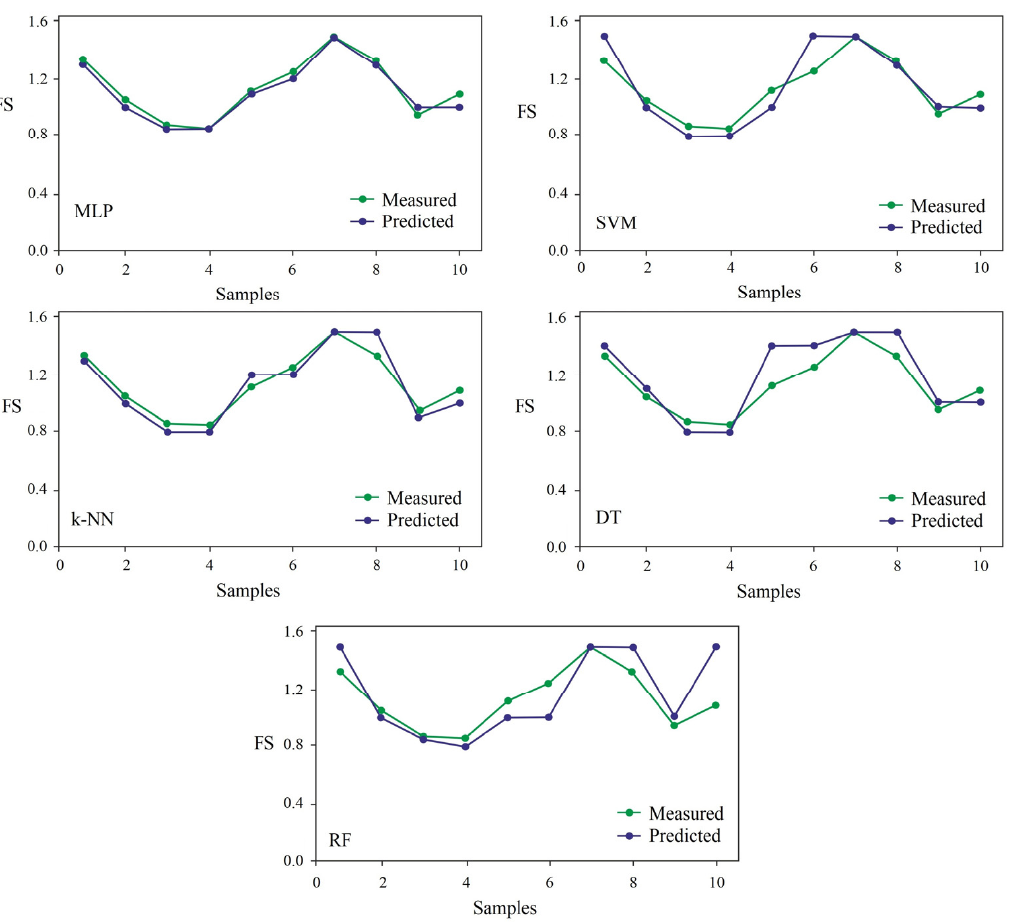
Figure 4. Results of the FS prediction in the testing set by machine learning-based models.